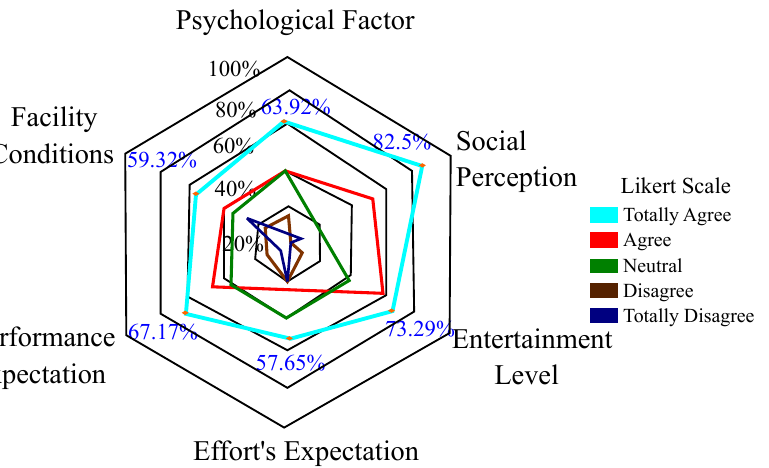
Figure 2. Overall perception (clinicians and patients) regarding the UTAUT Questionnaire results.